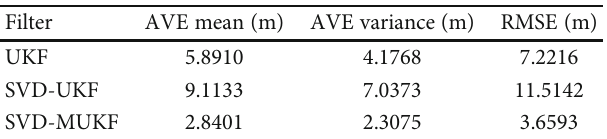
Figure 5: AVE for uniform linear motion estimation (displacement). Table 2: Mean, variance, and RMSE of algorithm displacement data.